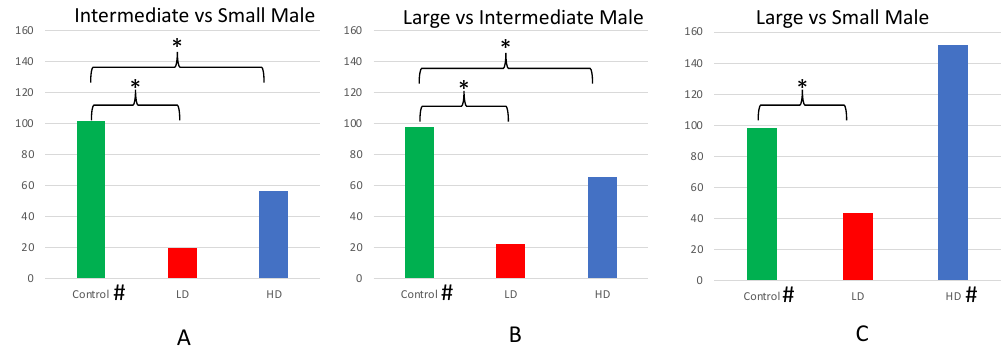
Figure 5. Comparison of mean female strength of preference (SOP) for larger male body size among the low-dose (red), high-dose (blue), and control (green) groups of expt. III. SOP is defined as the time spent with the larger male—time spent with the smaller male per trial ( A ) = ‘I vs. S’ pairing; ( B ) = ‘L vs. I’ pairing; ( C ) = ‘L vs. S’ pairing). # Indicates a significant preference for the larger of the paired males in a given trial (e.g., L vs. S) using paired sample t-tests. Starred brackets (*) indicate a significant difference in mean SOP between the treatment groups (e.g., control vs. LD).